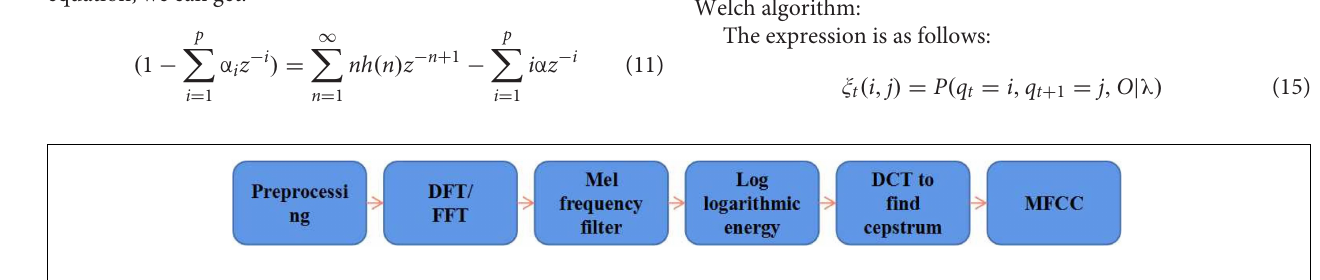
FIGURE 7 | Mel frequency cepstral coefficient extraction